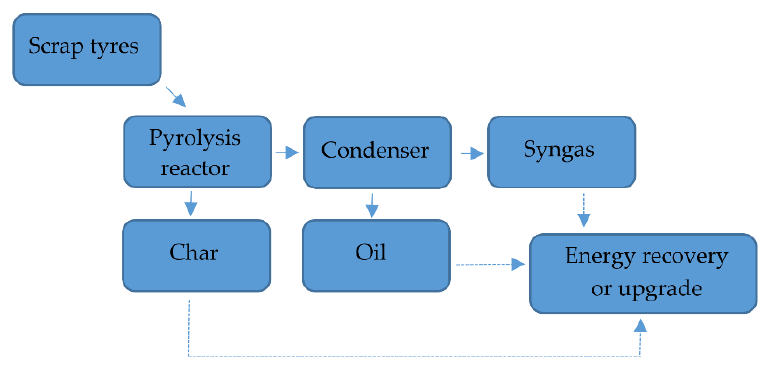
Figure 15. Scheme of pyrolysis Made based on [68].